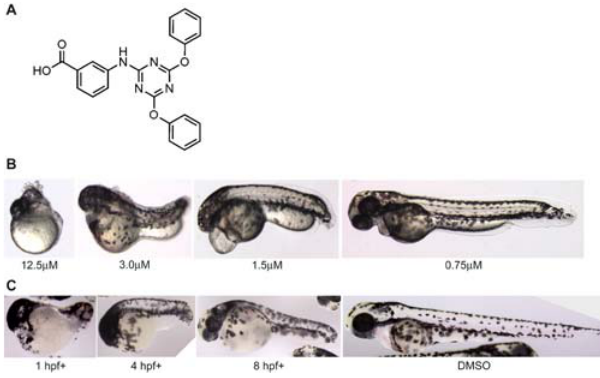
Figure 2. DTAB causes anterior-posterior axis defects. a) Chemical structure of DTAB. b) Embryos treated with higher concentrations of DTAB showed more anterior-posterior patterning defects than those treated with lower concentrations. Zebrafish embryos were treated from 1hpf to 48hpf with different concentrations of DTAB. c) Embryos treated earlier in development, and thus for longer duration were more severely affected than those treated later. Embryos were exposed to 3 m M DTAB from different times of development to 48hpf and compared to embryos treated with the vehicle DMSO. Vehicle (DMSO) treated controls developed normally. All observations were made at 48hpf.